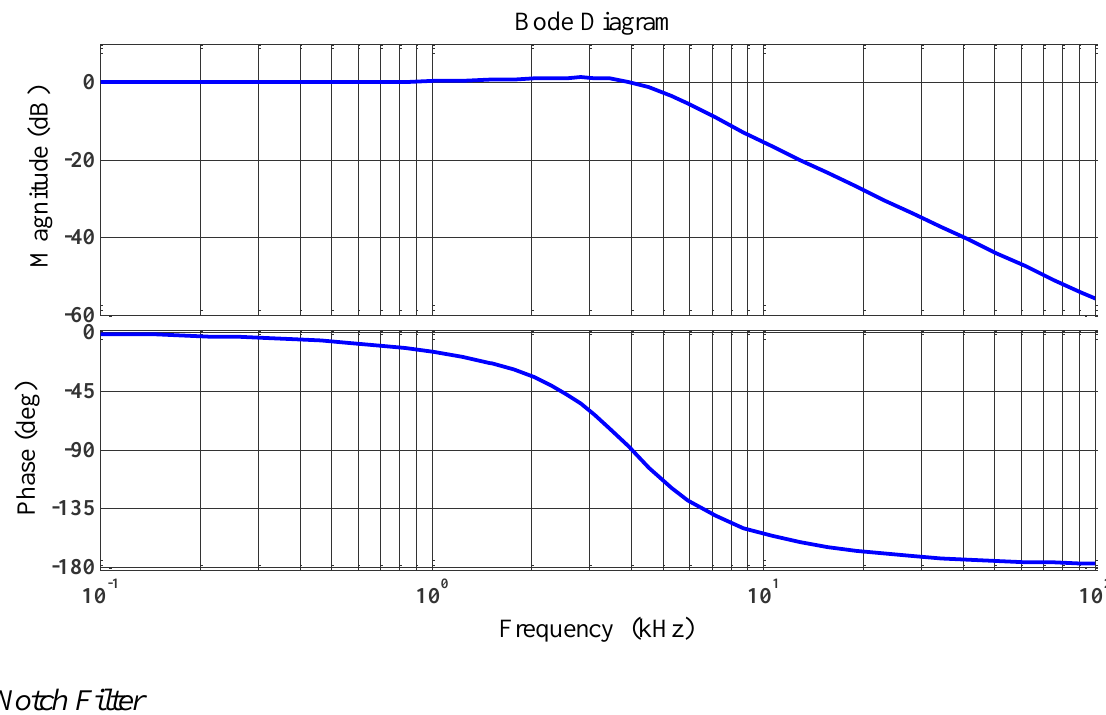
Figure 12. Frequency response for active low-pass filter using